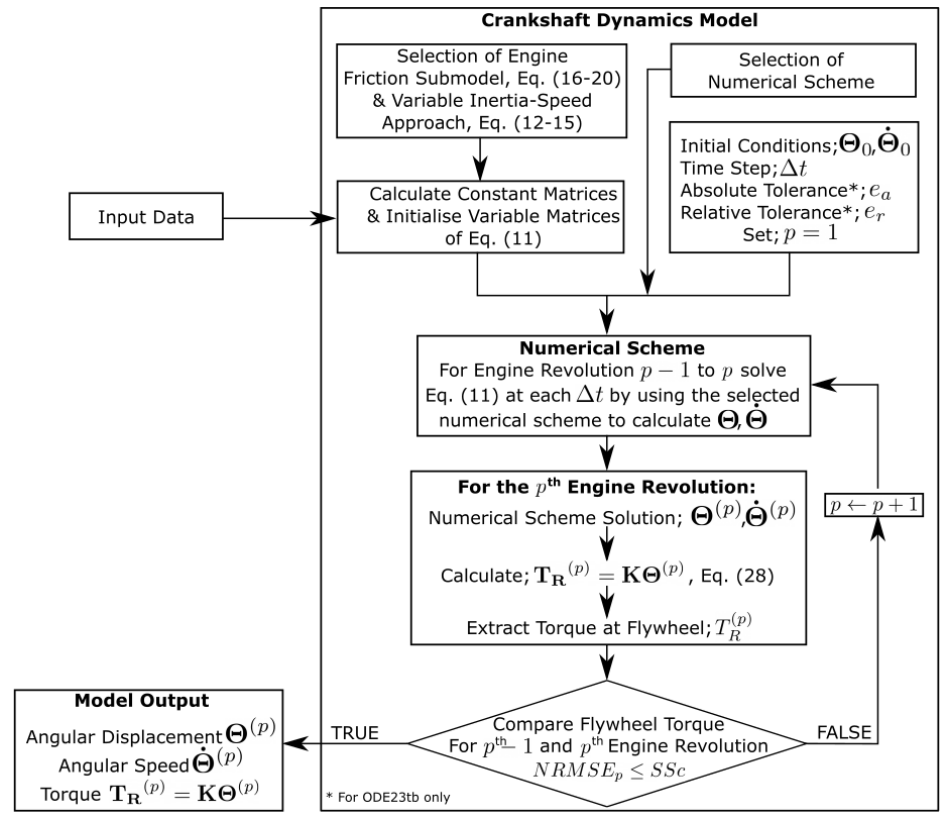
Figure 3. Crankshaft dynamics model flowchart. For the description of the Input Data refer to Figure 4. The matrices with superscript p horizontally concatenate the vectors from the governing equation solution for every time step included in the p th engine